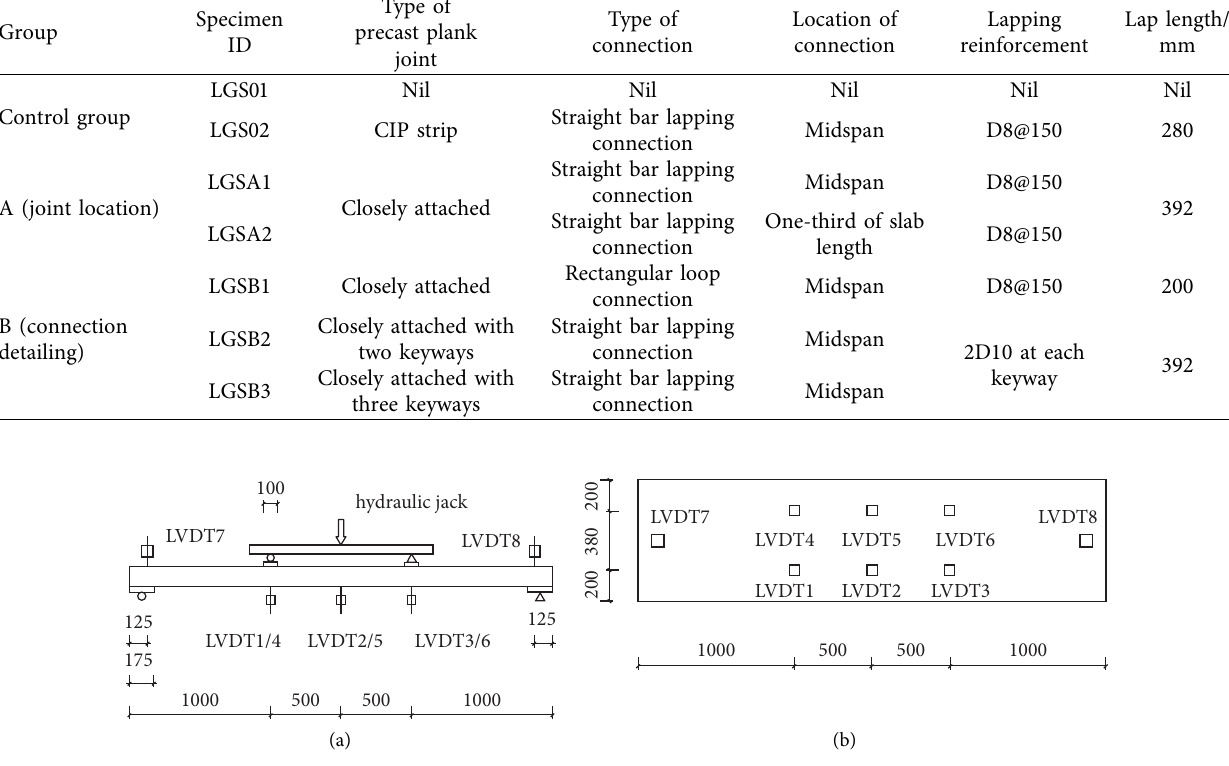
Figure 5: Test setup and instrument. (a) Setup. (b) LVDT